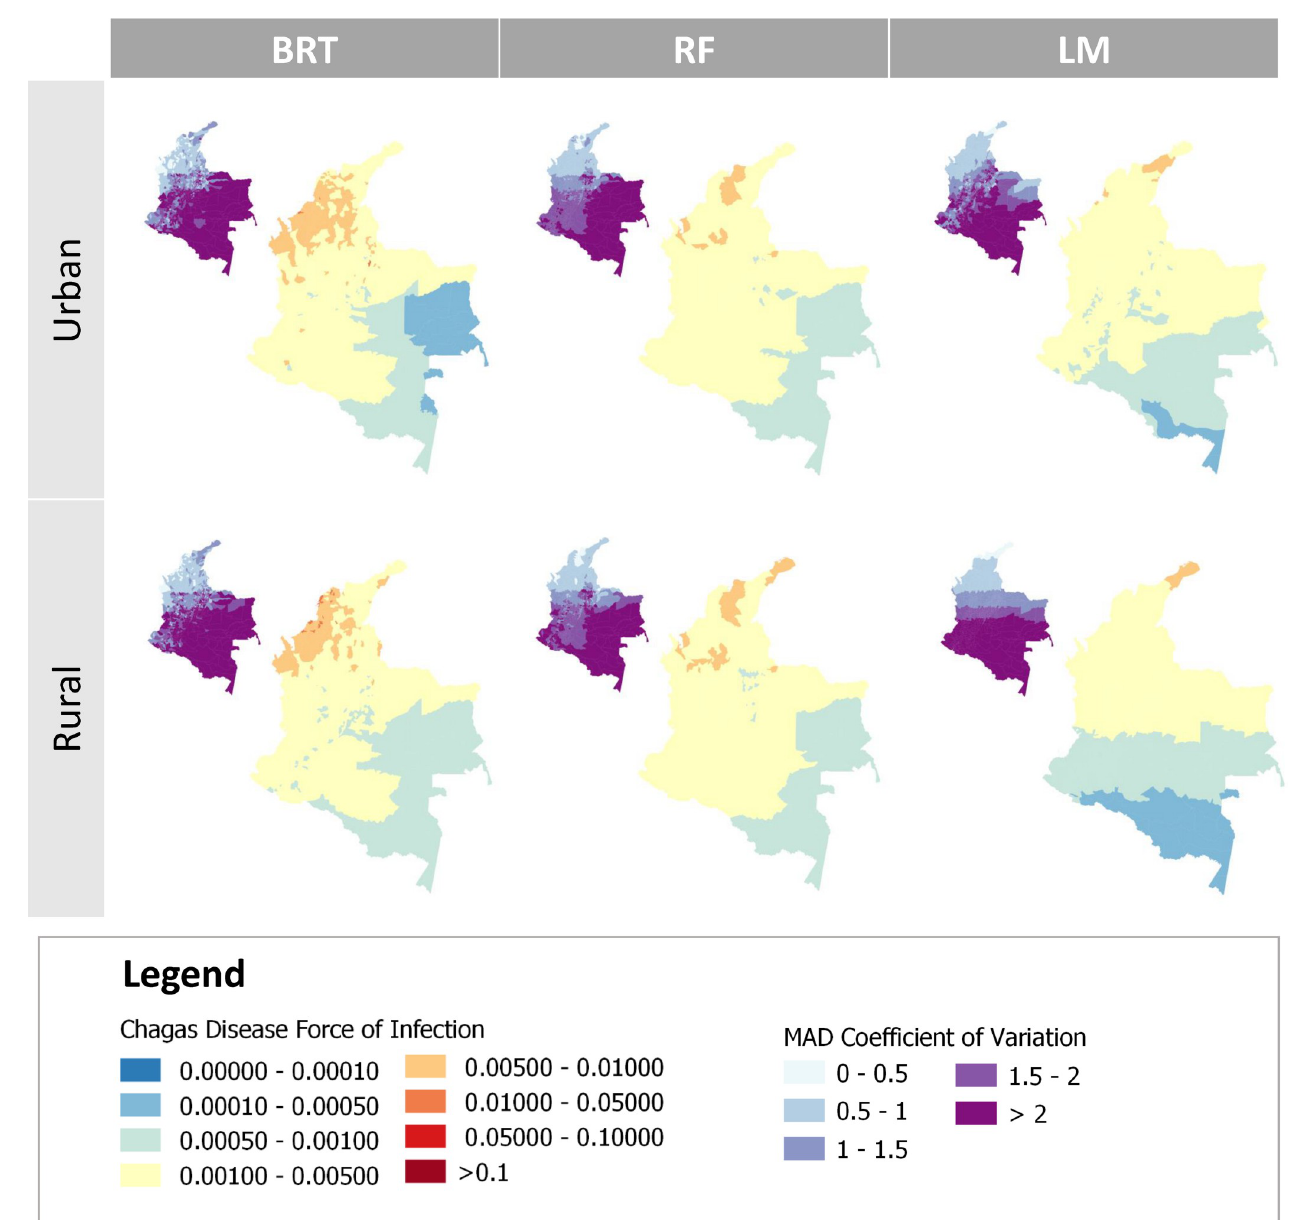
Fig 3. Spatial distribution of the Force-of-Infection of Chagas Disease (per year and per susceptible individual), in Colombia. The predicted distribution was generated using two Machine Learning (Boosted Regression Trees (BRT) and Random Forest (RF)) methods and a Linear Model (LM) framework (main maps); the associated uncertainty (small map insets) presents the Median Absolute Deviation (MAD) Coefficient of Variation (MAD-CV). Predictions were obtained at the municipality level for urban and rural settings, in 1990. (Borders shapefile at the ADM2 level obtained from GADM, https://gadm.org/